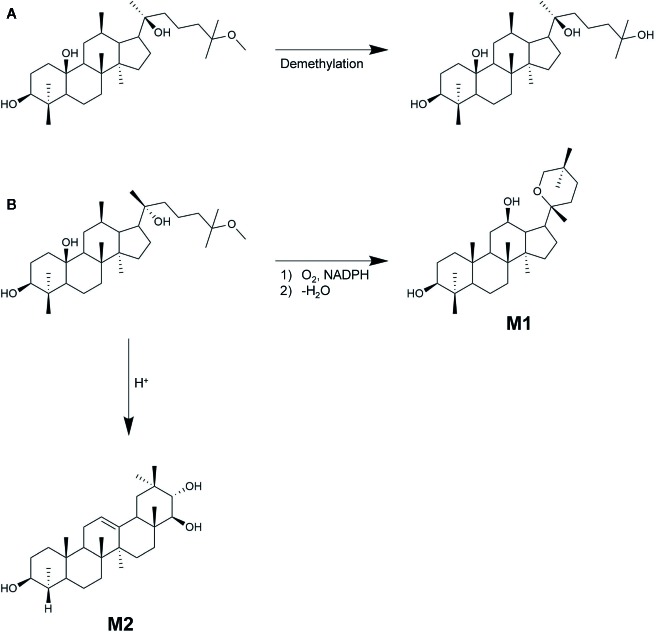
20(S/R)-25-OCH3-PPD metabolites. (A) 20(S)-25-OCH3-PPD metabolized to 20(S)-25-OH-PPD. (B) 20(R)-25-OCH3-PPD metabolized to 20(R)-PD (M1), and the oleanane triterpenoid saponin M2.